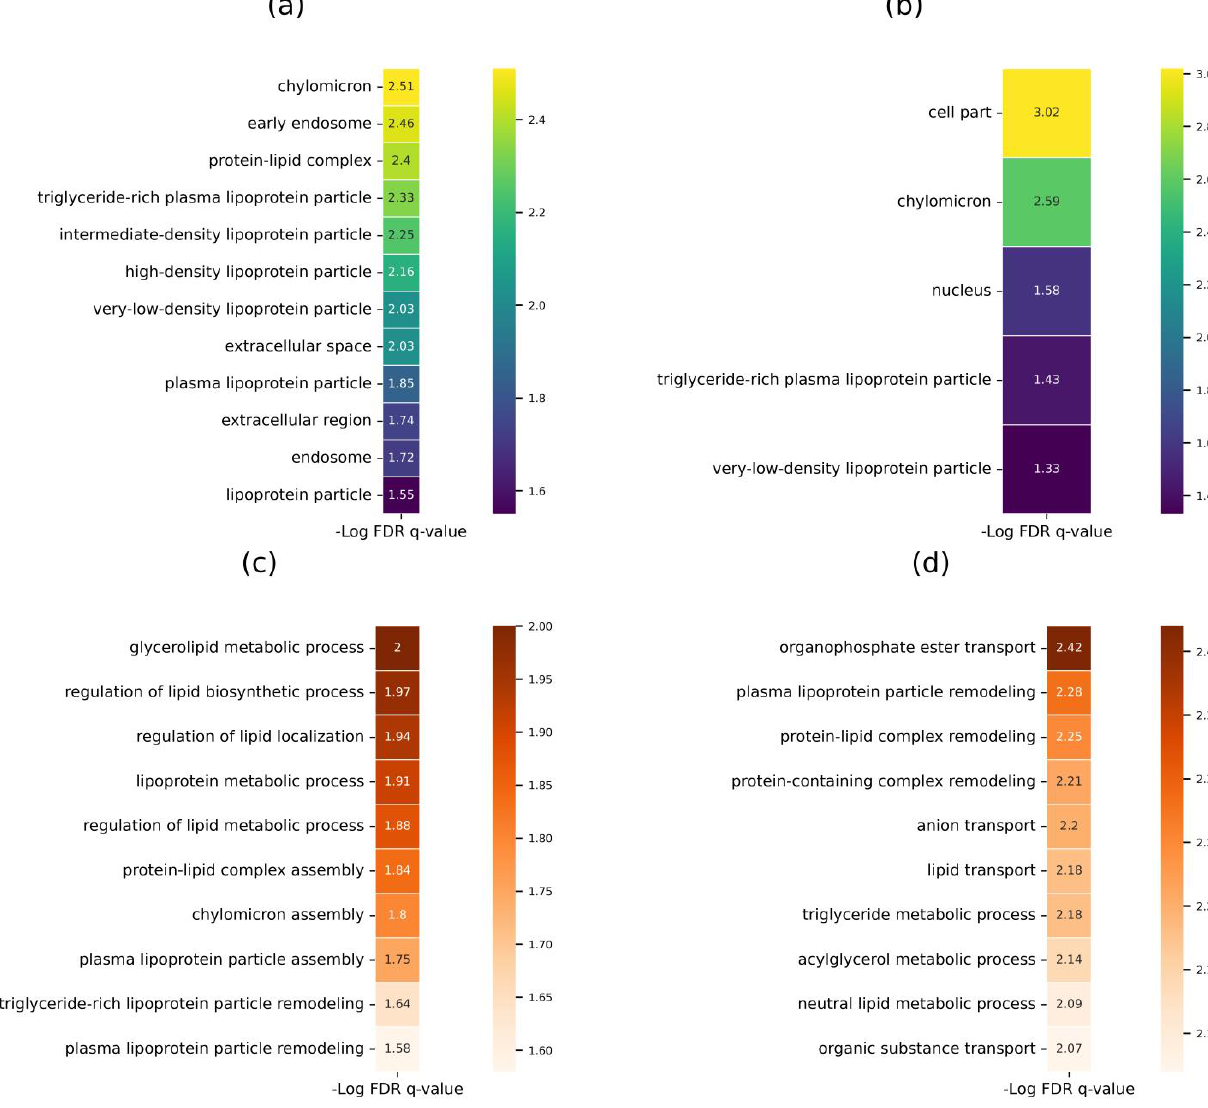
Figure 3. Gene Ontology enrichment analysis of the lists of respective proteins obtained using the SRM method. ( a ) Core proteins ( N = 53) belonging to the GO category “Cell Component” , ( b ) Variable proteins ( N = 243) belonging to the GO category “Cell Com- ponent” , (c) Core proteins ( N = 53) belonging to the GO category “Biological Processes” , ( d ) Variable proteins ( N = 243) belonging to the GO category “Biological Processes” . Core proteins (the most stable ones) are the proteins found in more than 70% of the sam- ples with CV <40%. Variable proteins are those found in less than 70% of the samples or have a CV